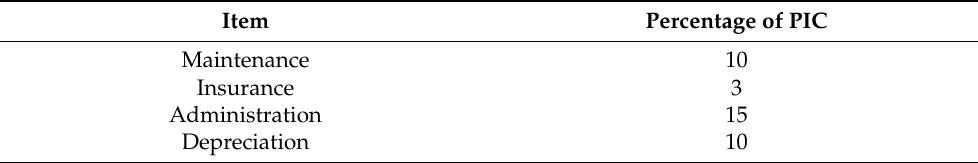
Table 7. Fixed cost breakdown.